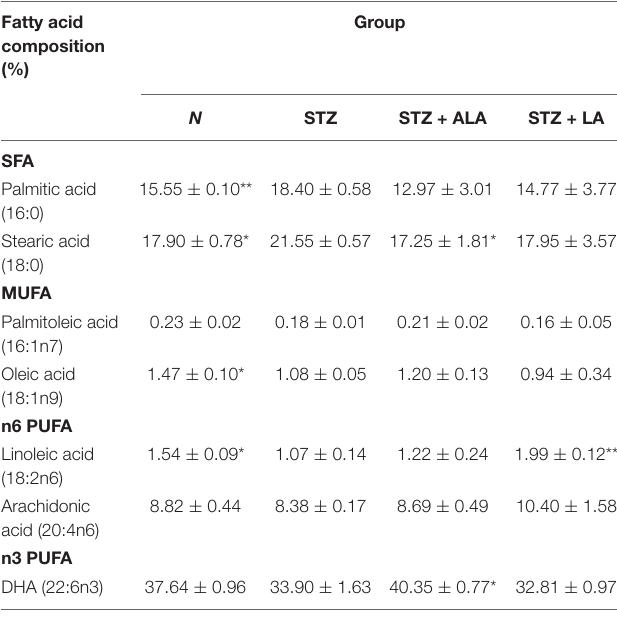
TABLE 3 | Retinal fatty acid composition of the experimental